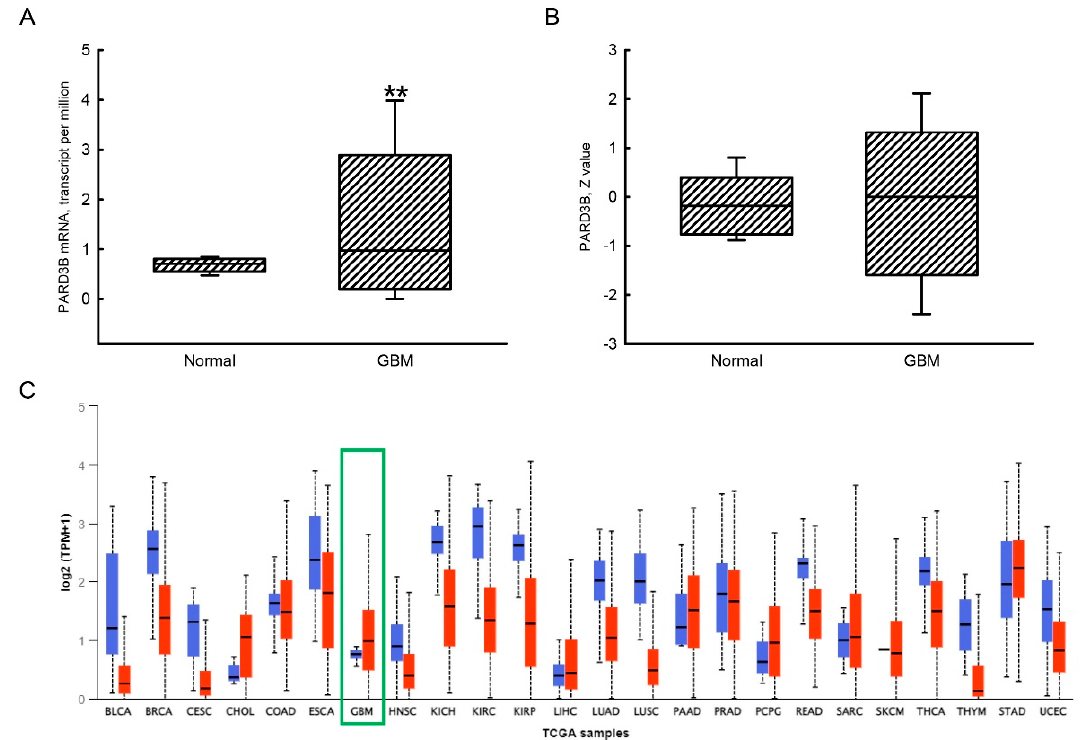
Figure 2. Increased expression of PARD3B mRNA in glioblastoma multiforme (GBM) tissues. Differential expressions of PARD3B mRNA in normal ( n = 5) and GBM ( n = 156) tissues were mined from The Cancer Genome Atlas (TCGA) database and analyzed by UALCAN (http://ualcan.path.uab.edu/ (accessed on 6 June 2022).) ( A ). Protein expression of PARD3B in normal ( n = 18) and GBM ( n = 125) tissues were mined and analyzed from UALCAN ( B ). Expressions of PARD3B mRNA across TCGA cancers in normal (blue bar) and tumor tissues (red bar) are further shown ( C ). Each value represents the minimum, lower quartile, median, upper quartile, and maximum. The symbol ** indicates that the value significantly differed from the respective normal group, p <